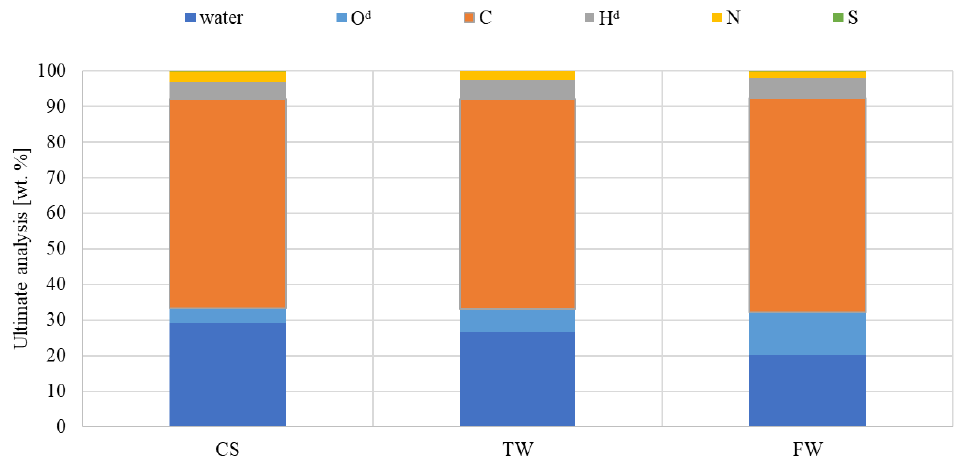
Figure 6. The ultimate analysis of liquid compounds generated under the same pyrolysis conditions (d—dry condition).